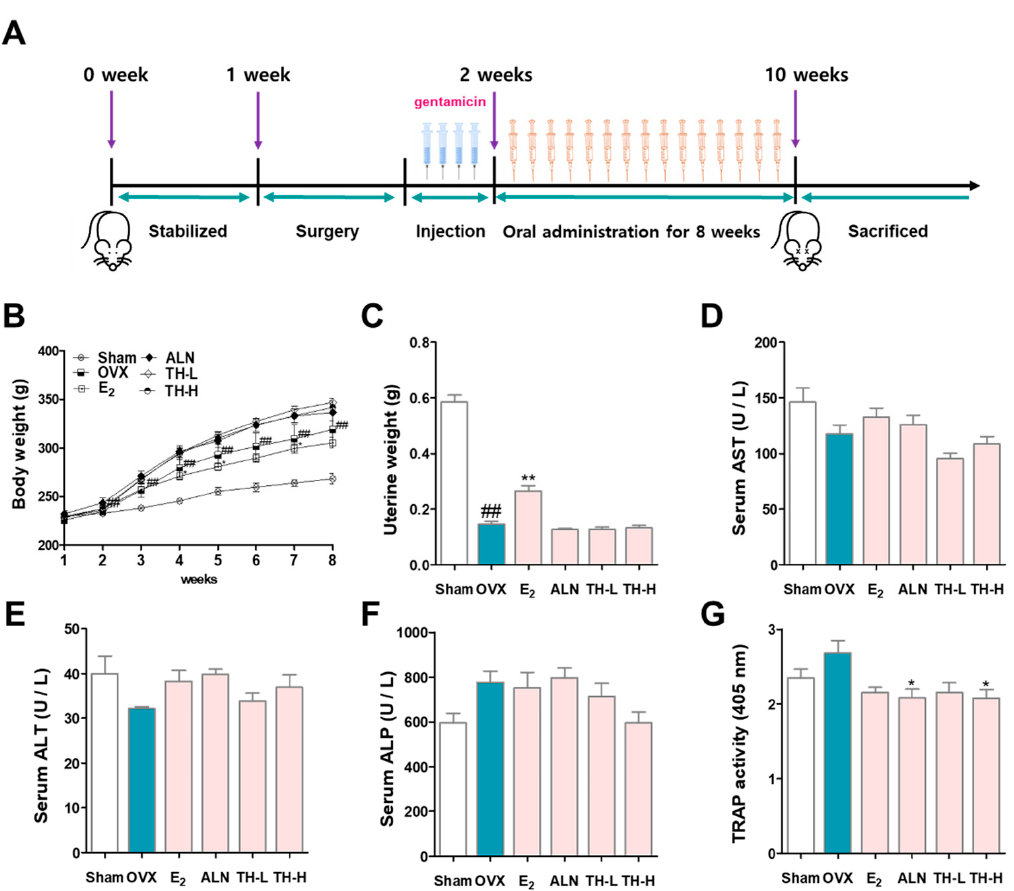
Figure 6. Taraxaci Herba (TH) administration improved bone reduction in the ovariectomy (OVX)- model. ( A ) Schedule of in vivo experiments for OVX-induced osteoclast differentiation in the SD rats. ( B ) All the animals were weighed once weekly at the same time. ( C ) At the time of sacrifice, uterine weights were taken and weighted. The levels of ( D ) aspartate aminotransferase (AST), ( E ) alanine aminotransferse (ALT), ( F ) alkaline phosphatase (ALP) and ( G ) tartrate-resistant acid phosphatase (TRAP) in the serum were analyzed through enzyme-linked immunosorbent assay (ELISA). The experiments’ representative images are shown, and the graphs are expressed as the mean standard error of the mean (SEM; n = 8). ## p < 0.01 vs. sham group; * p < 0.05, ** p < 0.01 vs. OVX group.